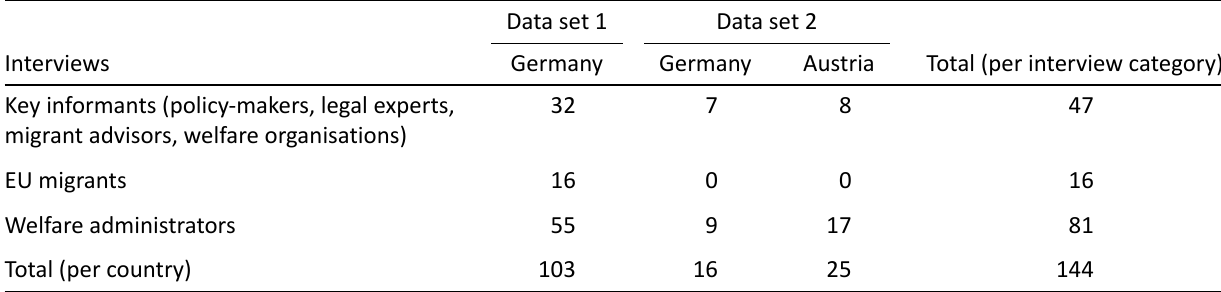
Table 1. Breakdown of in‐depth